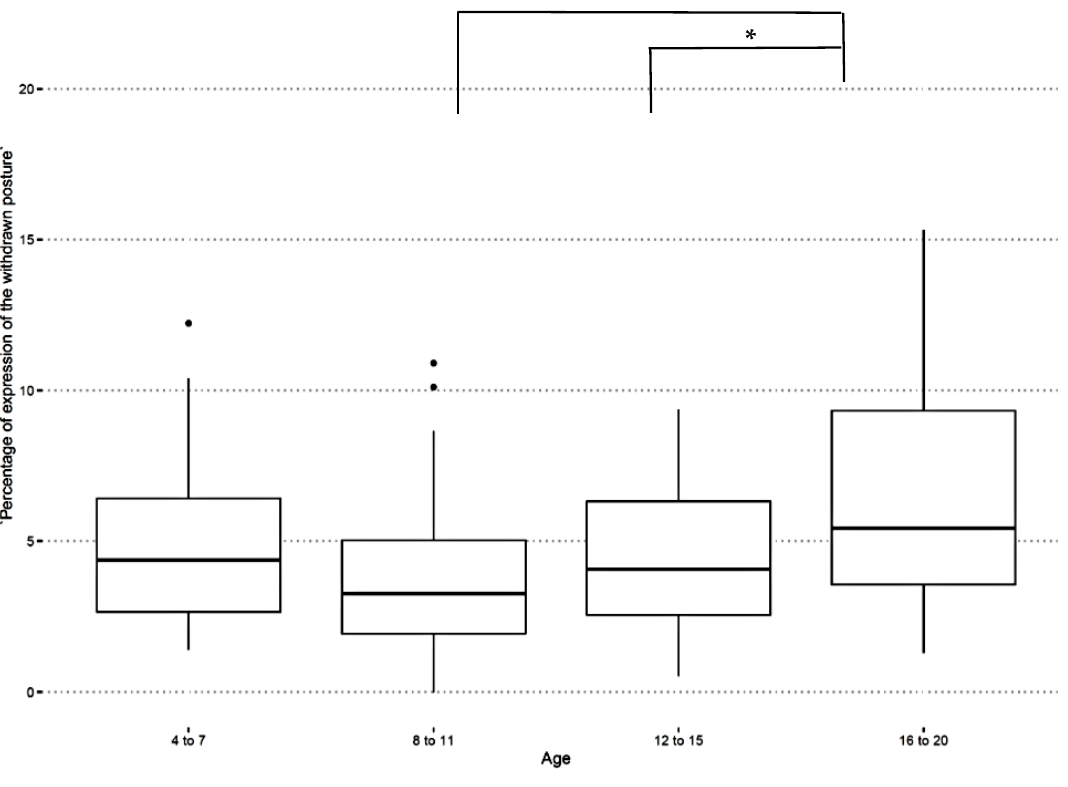
Figure 1. Percentage of expression of the “withdrawn posture” according to age categories. Horses aged between 8 to 11 and 12 to 15 were less unresponsive to the environment than those aged between 16 to 20 (Tukey post-hoc respectively: Z = 3.51, p = 0.002; Z = 2.62, p = 0.04). * ≤ 0.05; ** ≤ 0.01.